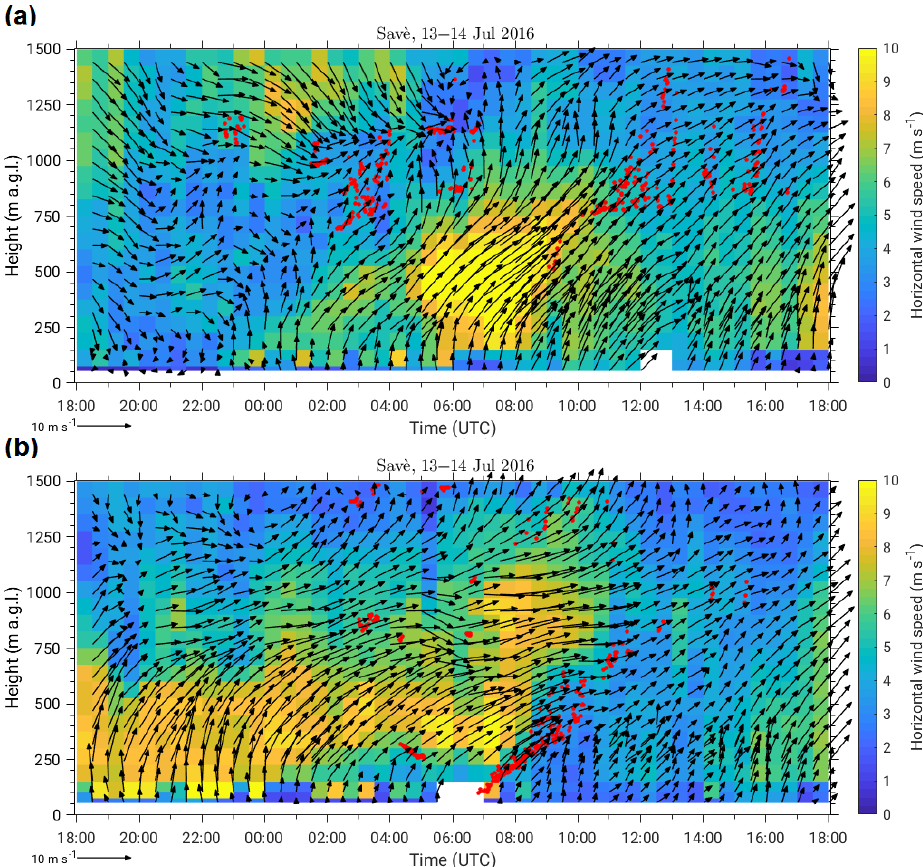
Figure 7. Time series of the wind speed and the wind direction at the Savè supersite during DACCIWA (Derrien et al., 2016). The wind speed is indicated in the colour bar and the direction with arrows (a leftwards horizontal arrow stands for wind direction from the east; an arrow from bottom to top is for south wind). The wind speed in the lowermost 1.5km was measured with the wind profiler of UPS from (a) 18:00UTC on 13 July 2016 until 18:00UTC on 14 July 2016 and (b) from 18:00UTC on 14 July 2016 to 18:00UTC on 15 July 2016. The red dots display the cloud base height measured with the